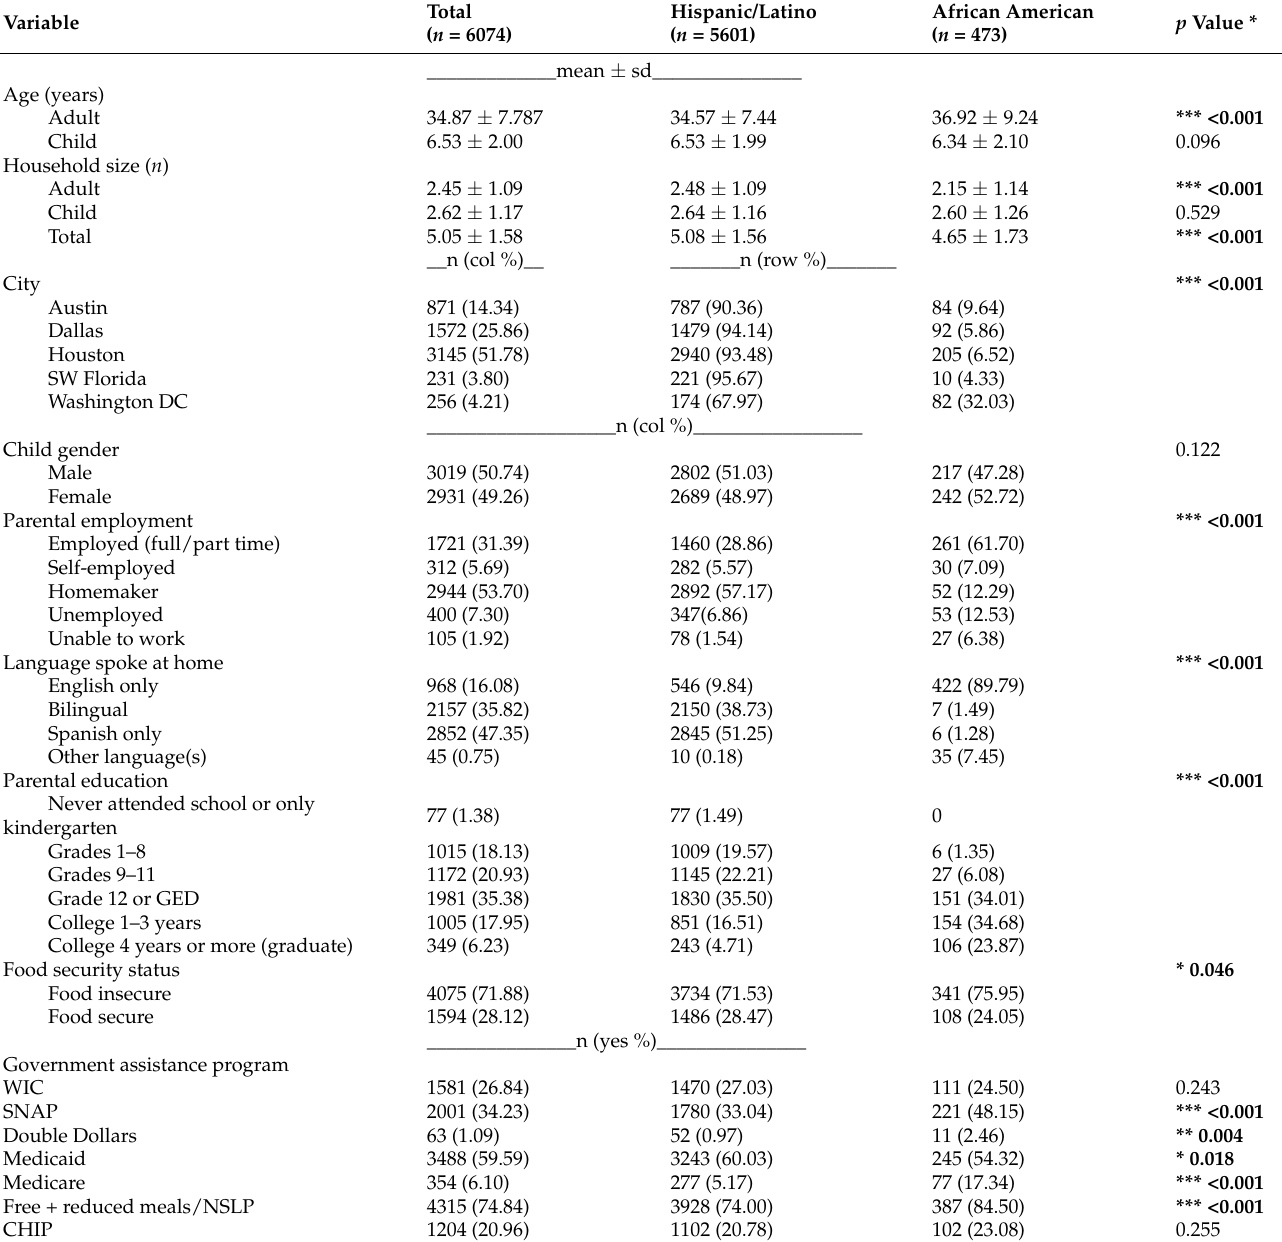
Table 1. Demographic Characteristics of Brighter Bites Participants ( n = 6074) Stratified by Race/Ethnicity, Fall 2018 Pre-Parent